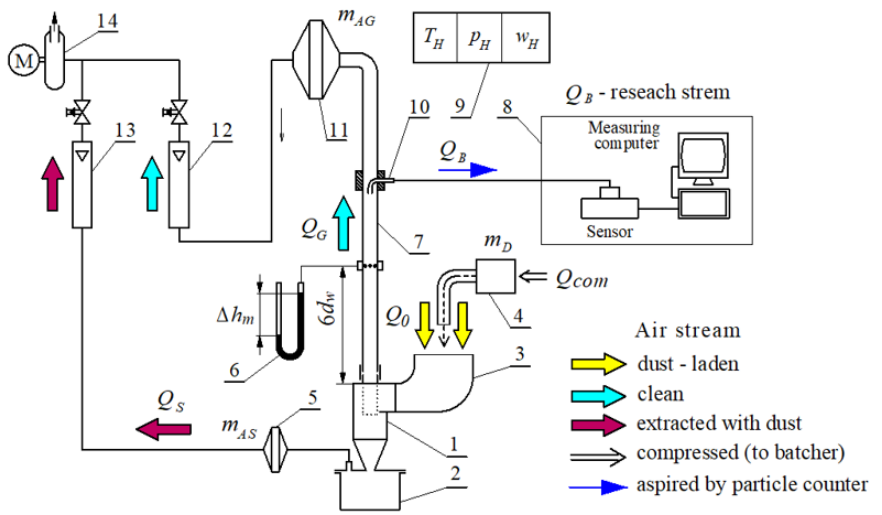
Figure 30. Schematic of cyclone test stand: 1—cyclone; 2—dust settler; 3—dust chamber; 4—dust dispenser; 5—absolute filter of dust extraction duct; 6—liquid manometer U-tube; 7—cyclone pressure drop measuring duct; 8—particle counter; 9—ambient air temperature, pressure and humidity measuring set; 10—measuring probe; 11—absolute filter of main duct; 12, 13—rotameters of main and extraction flux measuring, respectively; 14 — fan producing air flux.